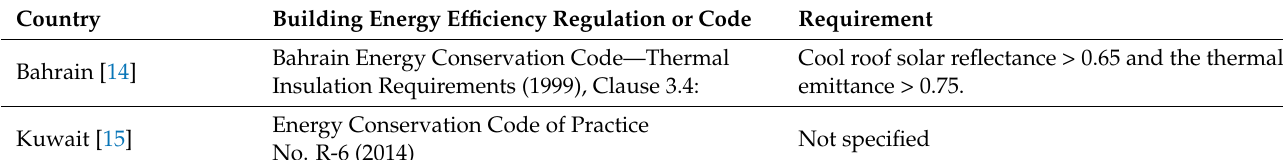
Table 1. Regulations or guidelines related to the use of high SRI materials for